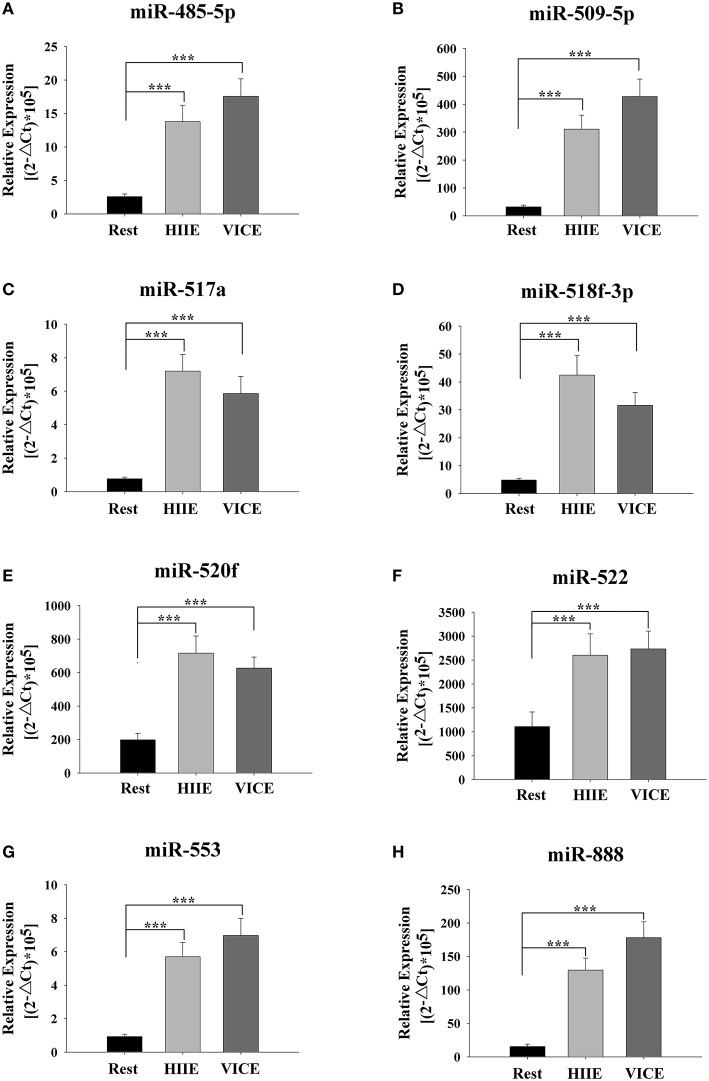
Non-muscle original c-miRNAs are elevated following high intensity interval exercise and vigorous intensity continuous exercise. Some tissue-related (A–F,H) or unknown originated (G) miRNAs in plasma were significantly increased following high intensity interval exercise (HIIE) and vigorous intensity continuous exercise (VICE). c-miRNA levels are displayed as relative levels based on the formula (2−▵Ct × 105). Values represent the mean ± SEM obtained from 26 subjects. ***Indicates differences compared to Rest, P < 0.001.